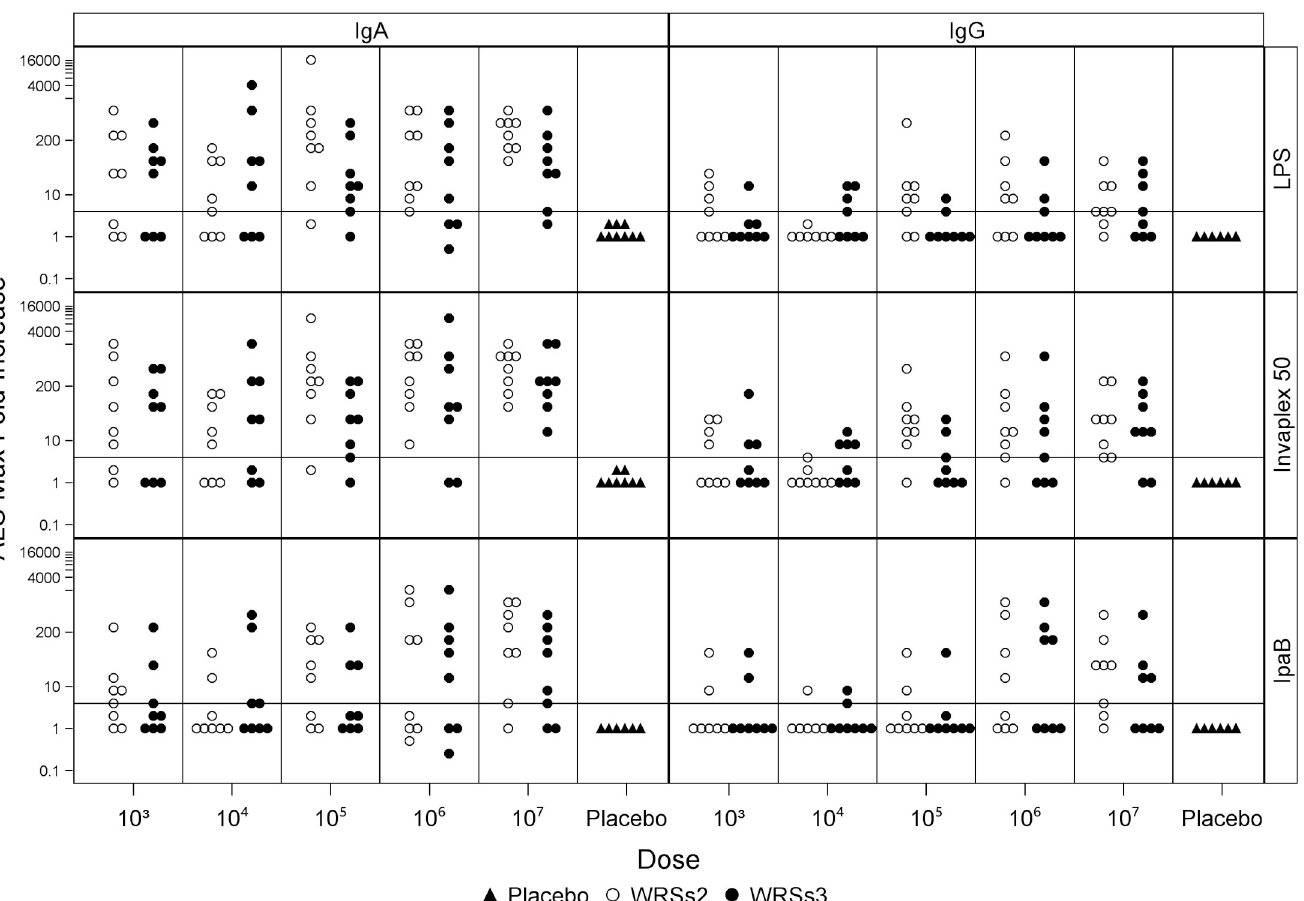
Fig 1. ALS maximum fold increase per cohort. The data are presented as the maximum fold increase of ALS IgA/IgG titer over baseline for each subject in each vaccine dose group. The open circles represent WRSs2 vaccinated subjects, the closed circles represent WRSs3 vaccinated subjects and the triangles represent placebo- immunized subjects. The Y-axis gives the maximum fold increase of IgA (left panel) and IgG (right panel) ALS titer of individual subjects to S . sonnei antigens LPS, IVP and IpaB shown on the X axis (CFU doses of the vaccine). The thin horizontal line shows the level of the 4-fold increase that defined a responder.